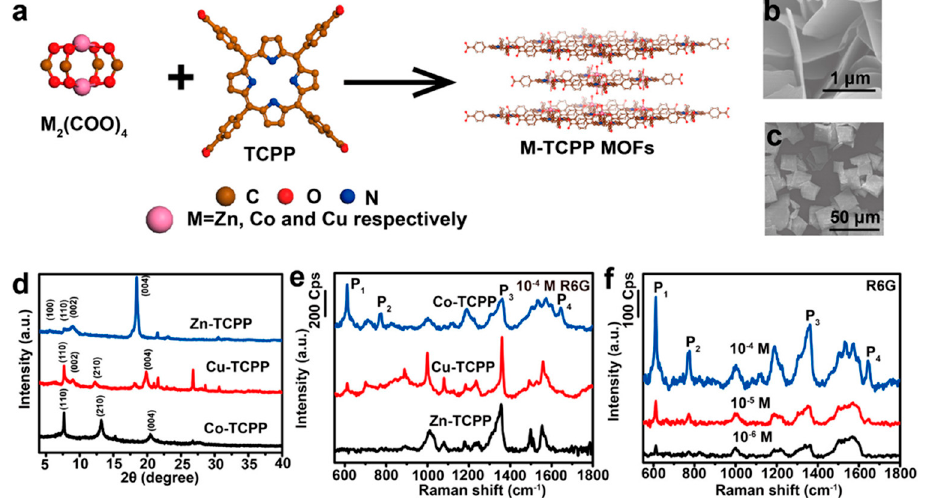
Figure 6. Structure and SERS effect of M-TCPP MOF. ( a ) Illustration of the process of synthesizing the M-TCPP (M = Zn, Co, and Cu) MOFs. ( b , c ) SEM images of the Cu-TCPP MOFs and Zn-TCPP MOFs. ( d ) PXRD patterns of the Co-TCPP MOFs, Zn-TCPP MOFs, and Cu-TCPP MOFs. ( e ) SERS spectra of R6G (10 − 4 M) on the Co-TCPP, Zn-TCPP, and Cu-TCPP substrates. ( f ) SERS spectra of R6G on the Co-TCPP substrate at three different concentrations: 10 − 4 , 10 − 5 , and 10 − 6 M [114]. Copyright 2019, American Chemical Society.